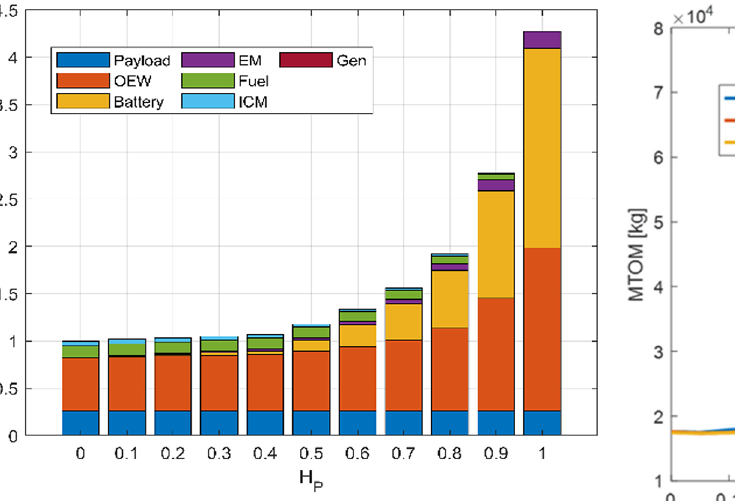
Fig. 10. Mass breakdown for a parallel hybrid-electric archi- tecture with a constant wing load of 290 kg/m 2 and a BED = 1000 Wh/kg [19]. Table 5. Sources of electrical energy production in EU.